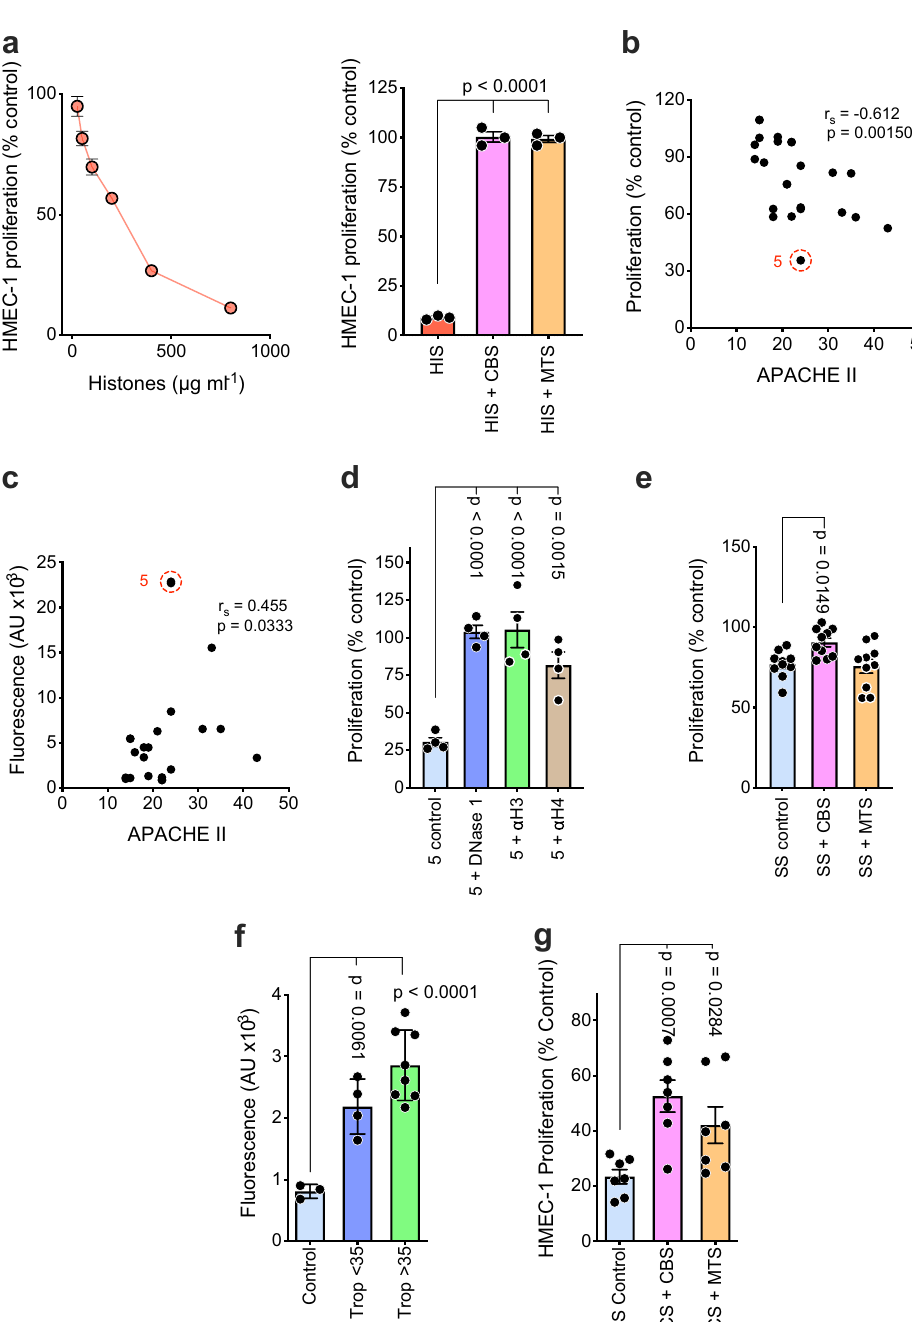
Fig. 7 Sera from sepsis and acute myocardial infarction patients inhibit endothelial cell proliferation, an effect neutralized by DNase I, anti-histone antibodies, and SPAs. a Proliferation of HMEC-1, as measured by 3 H-thymidine incorporation, to detect the anti-proliferative activity of histones, which is histone concentration dependent (left panel, n = 3), but is totally neutralized by mCBS and MTS (right panel, n = 3). b Correlation (Spearman ’ s r value) of APACHE II scores with anti-proliferative effect of sepsis patients sera on HMEC-1 ( n = 20 patients). c Correlation of APACHE II scores with extracellular DNA content of sepsis patient ’ s sera, with serum from patient 5 (red circle) having greatest anti-proliferative activity ( b ) and DNA content ( c ). d Effect of DNase I or pAbs against histone 3 ( α H3 10 μ g ml − 1 ) and histone 4 ( α H4 10 μ g ml − 1 ) ( n = 4/treatment) on anti-proliferative effect of serum from sepsis patient 5. e Ability of SPAs CBS and MTS to neutralize the anti-proliferative effect of sepsis patient sera (SS) ( n = 10 patients). f Extracellular DNA content of occlusion site sera from STEMI patients ( n = 12) and strati fi ed according to low (<35 µ mol l − 1 , n = 4) and high (>35 µ mol l − 1 , n = 8) troponin I (Trop) levels. Control sera ( n = 3) from the peripheral blood of healthy volunteers. g Ability of SPAs CBS and MTS to neutralize the HMEC-1 anti-proliferative effect of sera from high troponin I STEMI patients (CS) ( n = 7 patients). Data are presented as mean ± s.e.m. and analyzed by one-way ANOVA with Dunnett ’ s correction for multiple comparisons. Source data are provided as a Source Data